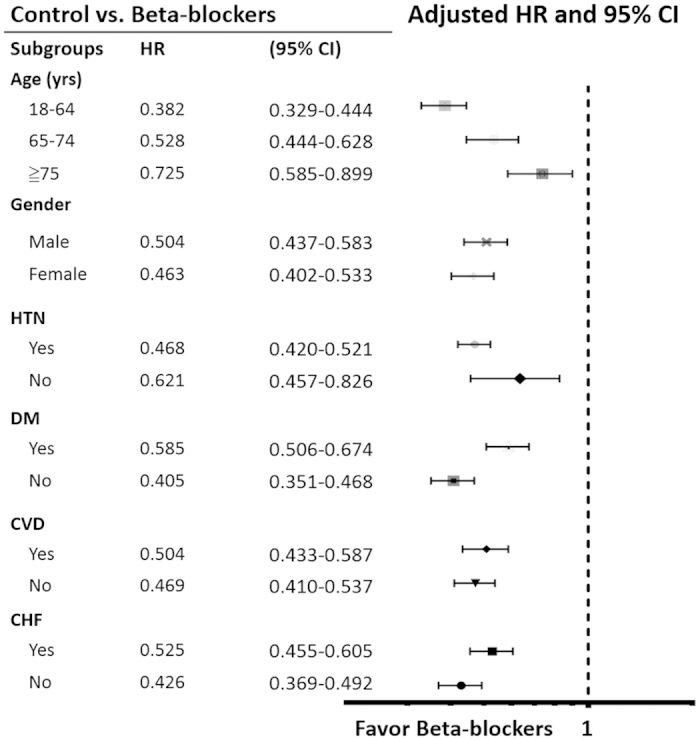
Relative risks of atrial fibrillation between patients with and without beta-blocker treatment, stratified by specific subgroups.